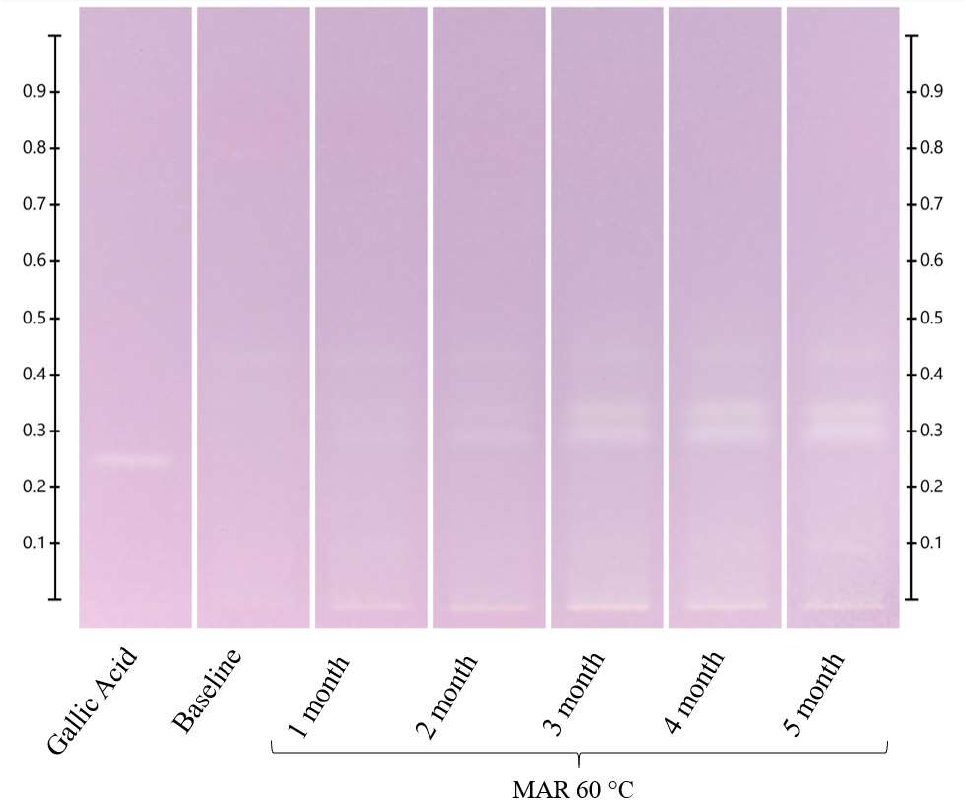
Figure 10. HPTLC-DPPH fingerprints of MAR honey stored at 60 °C for up to 5 months. Images of the HPTLC plate were taken under white light after 60 min of derivatization with DPPH* reagents, gallic acid (4 μL) and honey extracts (5 μL), respectively.